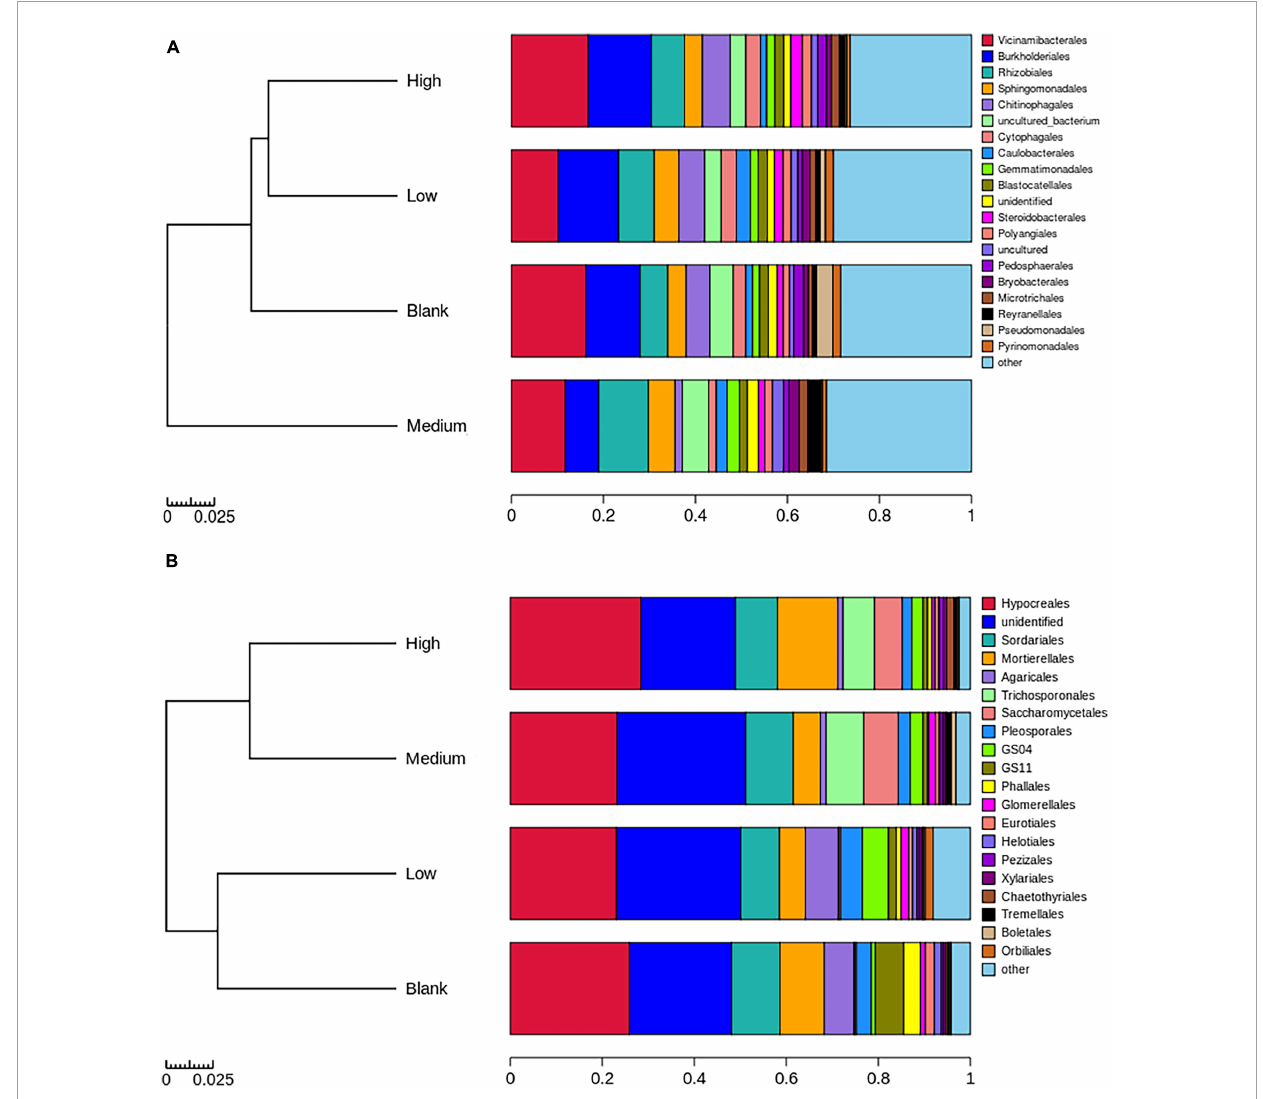
FIGURE5 Relative species abundance and unweighted UniFrac distance of panel (A) bacterial and (B) fungal orders under different radiation intensities.